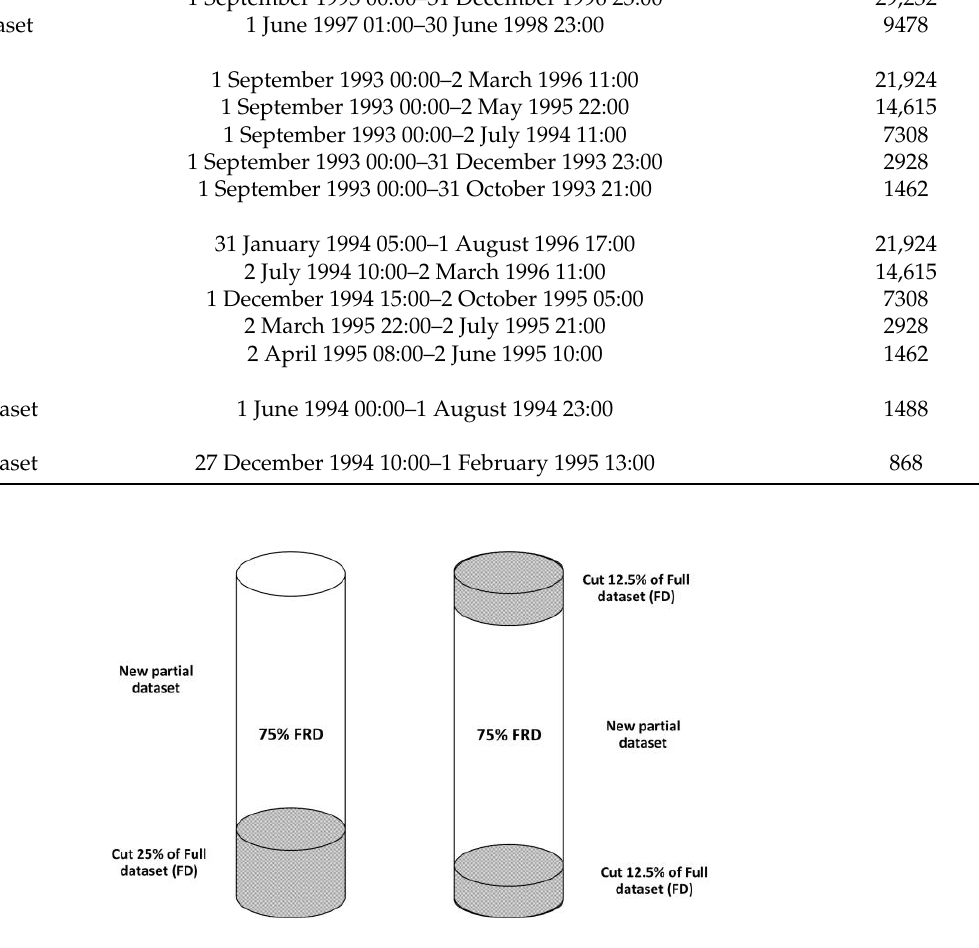
Figure 3. Example of two scenarios to obtain 75% Fraction Retained Dataset (FRD) of the full dataset (FD): scenario 1 ( left ) and scenario 2 ( right ). Table 2. Datasets used in the study.